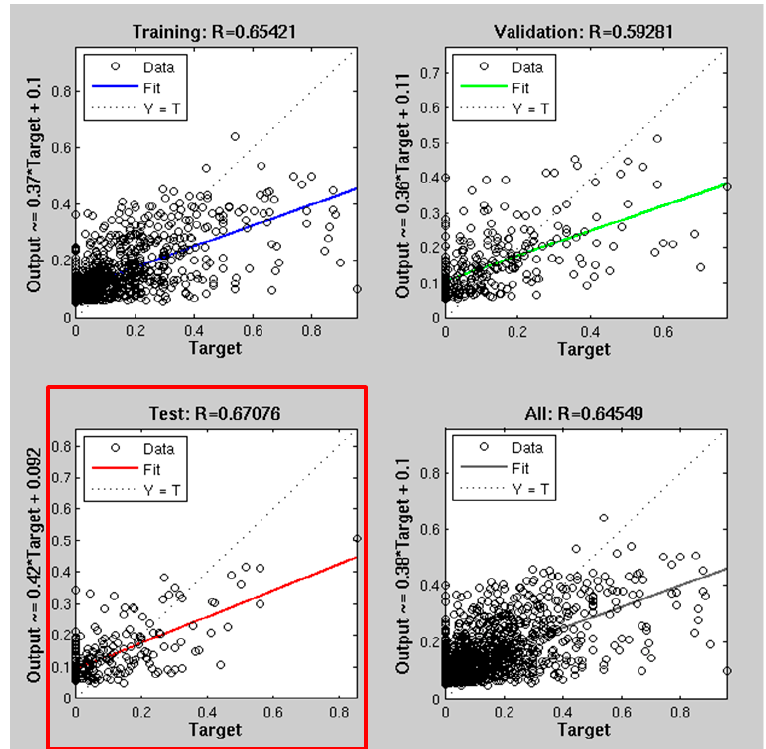
Figure 4. Regression curves for training, cross validation, test and total sets, considering Exp 1. Red squared regression curves describe the result obtained when an independent dataset is applied.